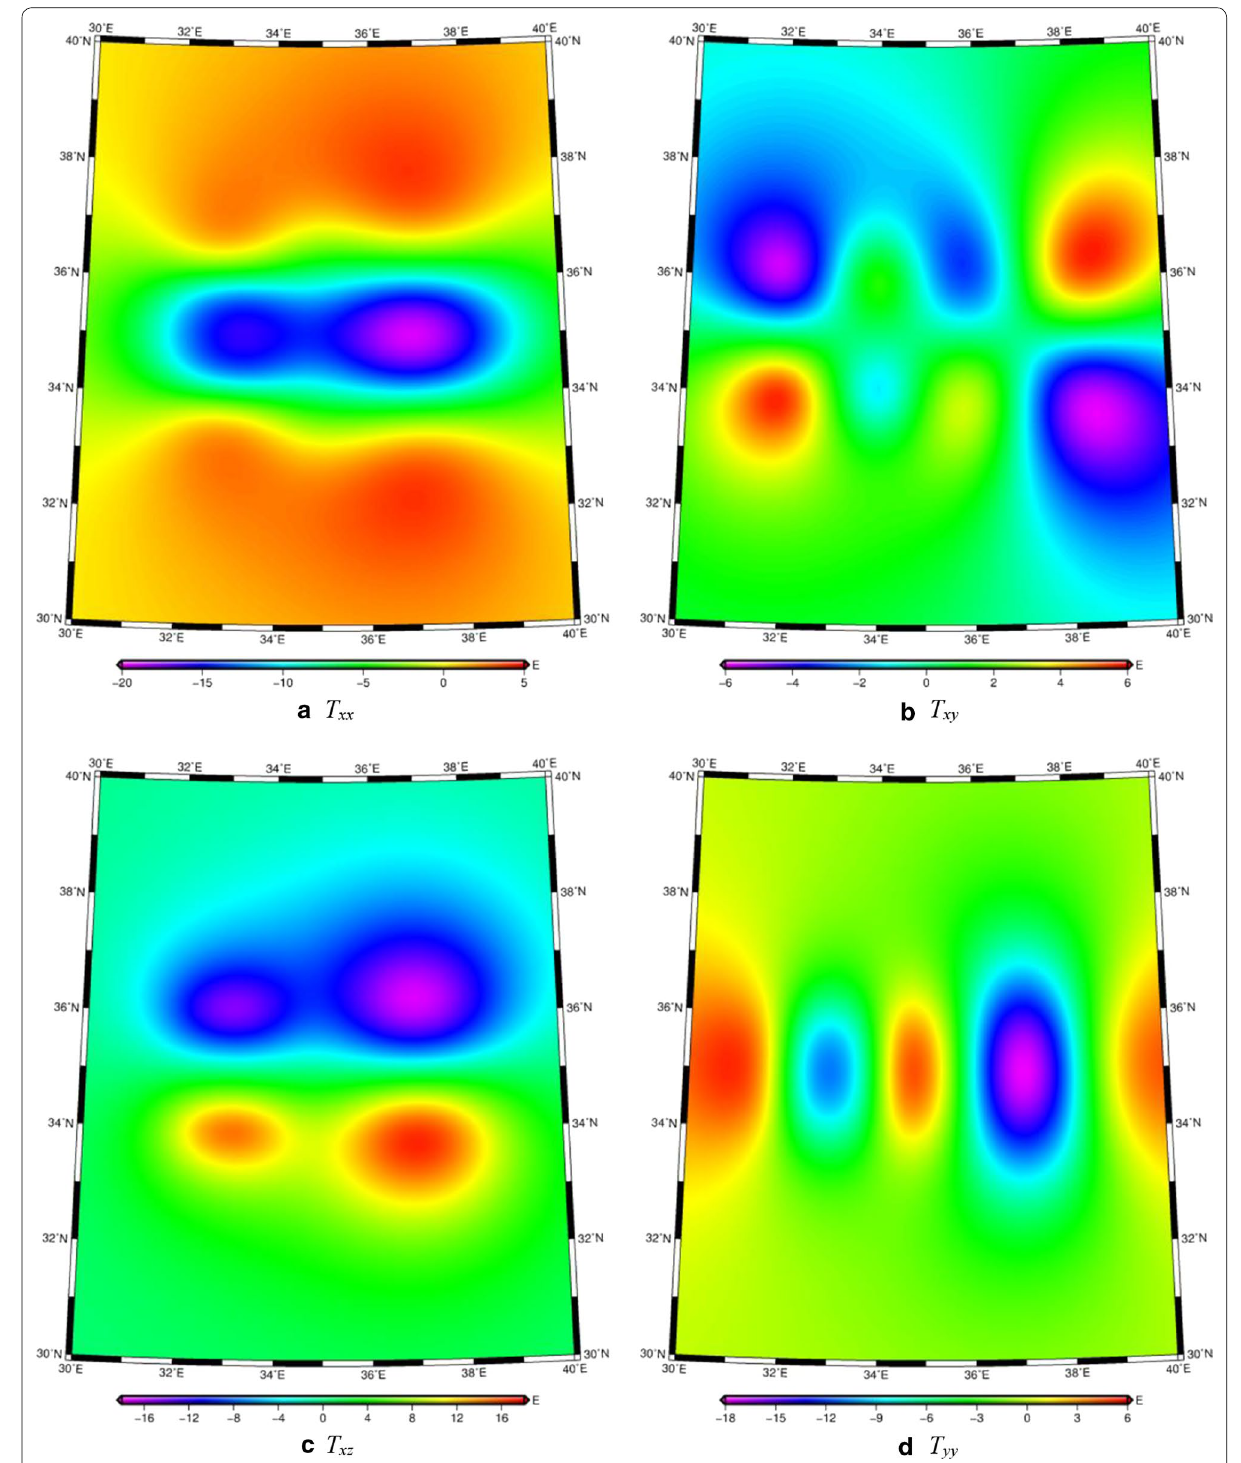
Fig. 9 Artificial theoretical datasets of the GGT for composite models, a , b , c and d are T xx , T xy , T xz and T yy components,